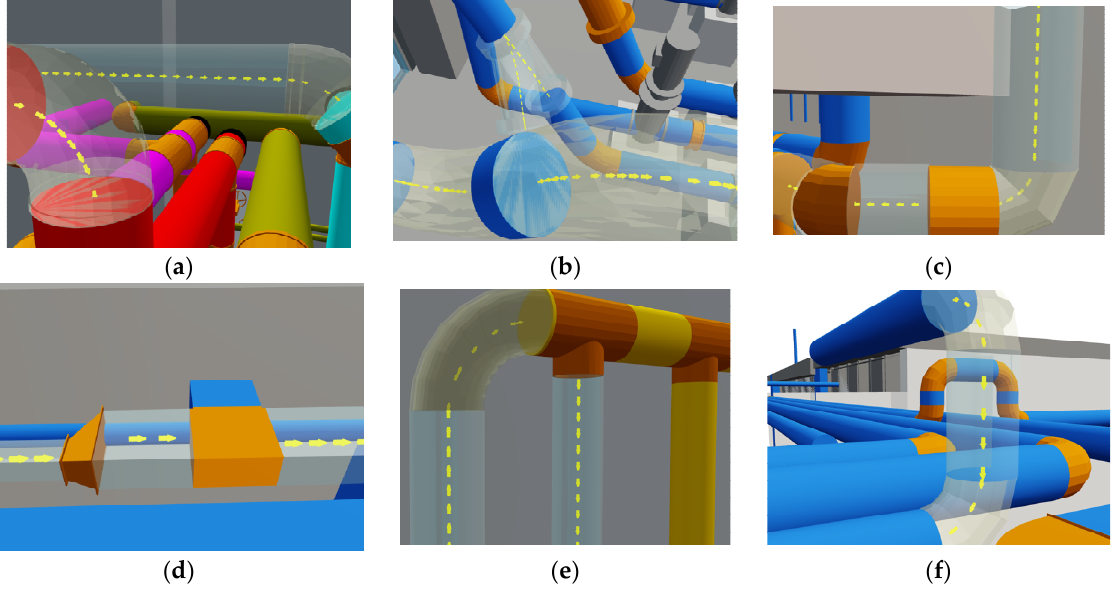
Figure 18. Directed representative edges from six BIM models. ( a ) #1, ( b ) #2, ( c ) #3, ( d ) #4, ( e ) #5, ( f ) #6.